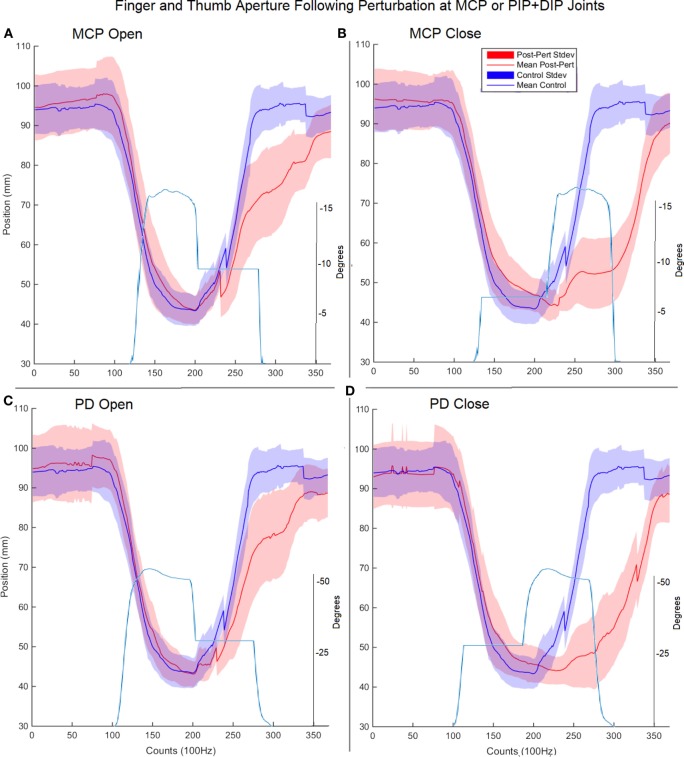
Finger and thumb aperture during perturbed (red) and unperturbed (blue) trials following perturbations. Each perturbation condition is shown, (A) metacarpophalangeal (MCP) perturbation during opening, (B) MCP perturbation during closing, (C) proximal interphalangeal (PIP)/distal interphalangeal (DIP) joint during opening, (D) PIP/DIP during closing. Examples of joint angle trajectories with perturbations are provided for reference; note, flat region indicates joint-locked perturbation.